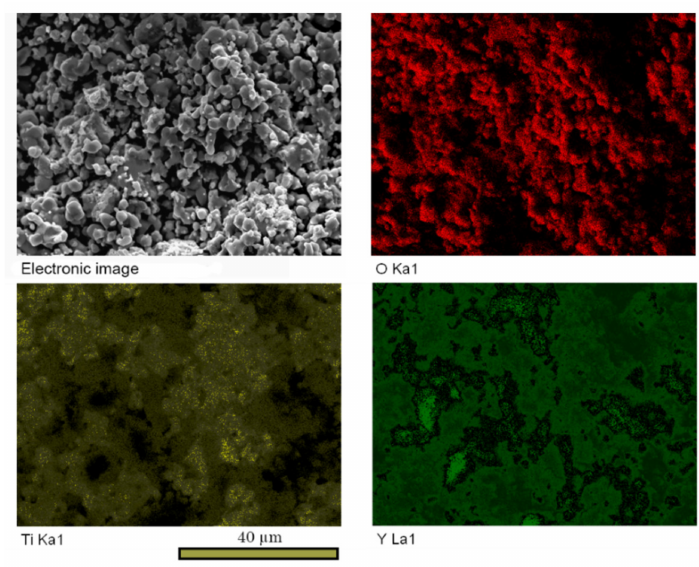
Figure 4. The sintered sample fracture SEM images and maps of element distribution after 25 h at 1150 ◦